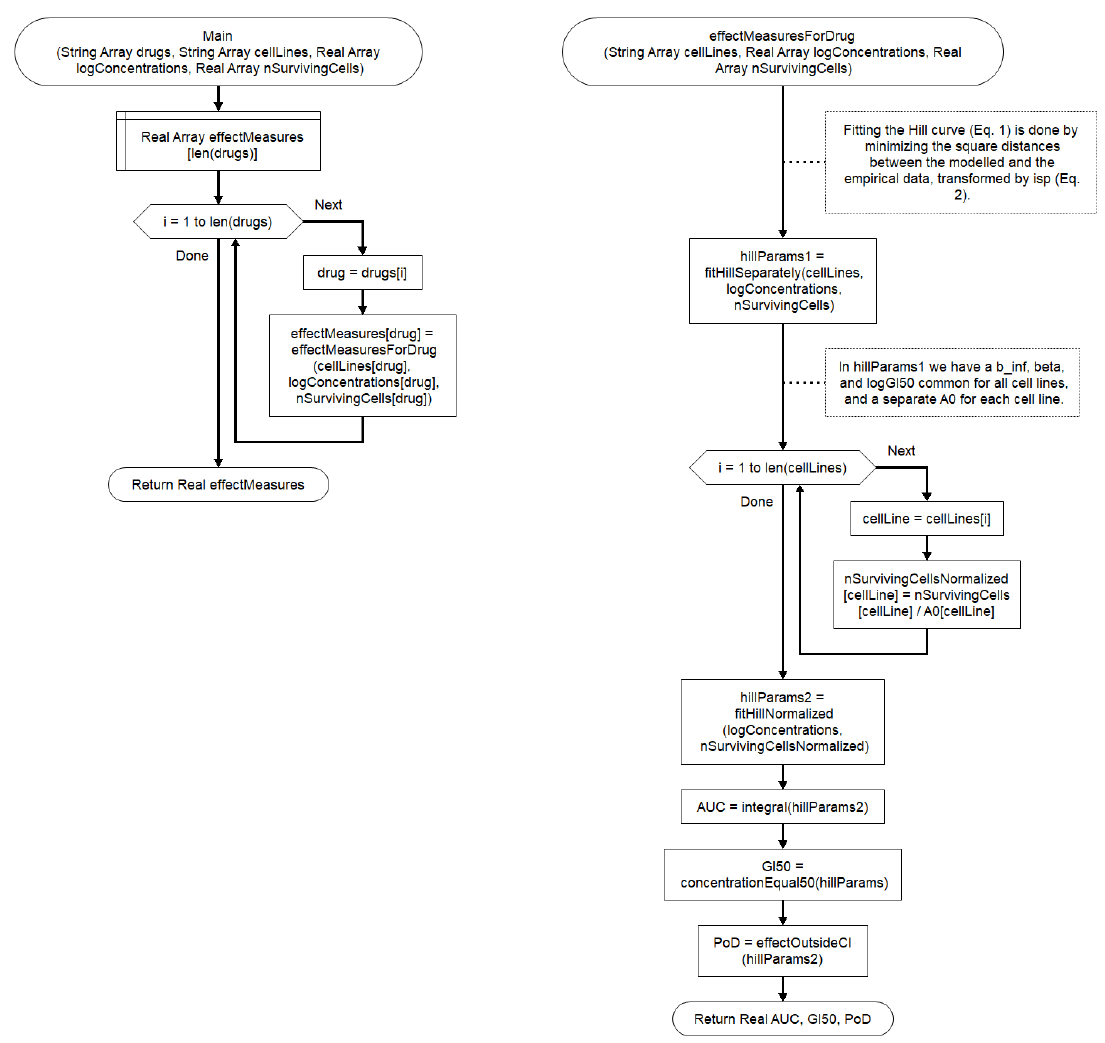
Figure 4. The workflow for calculating the effect measures for all drugs and cell lines.